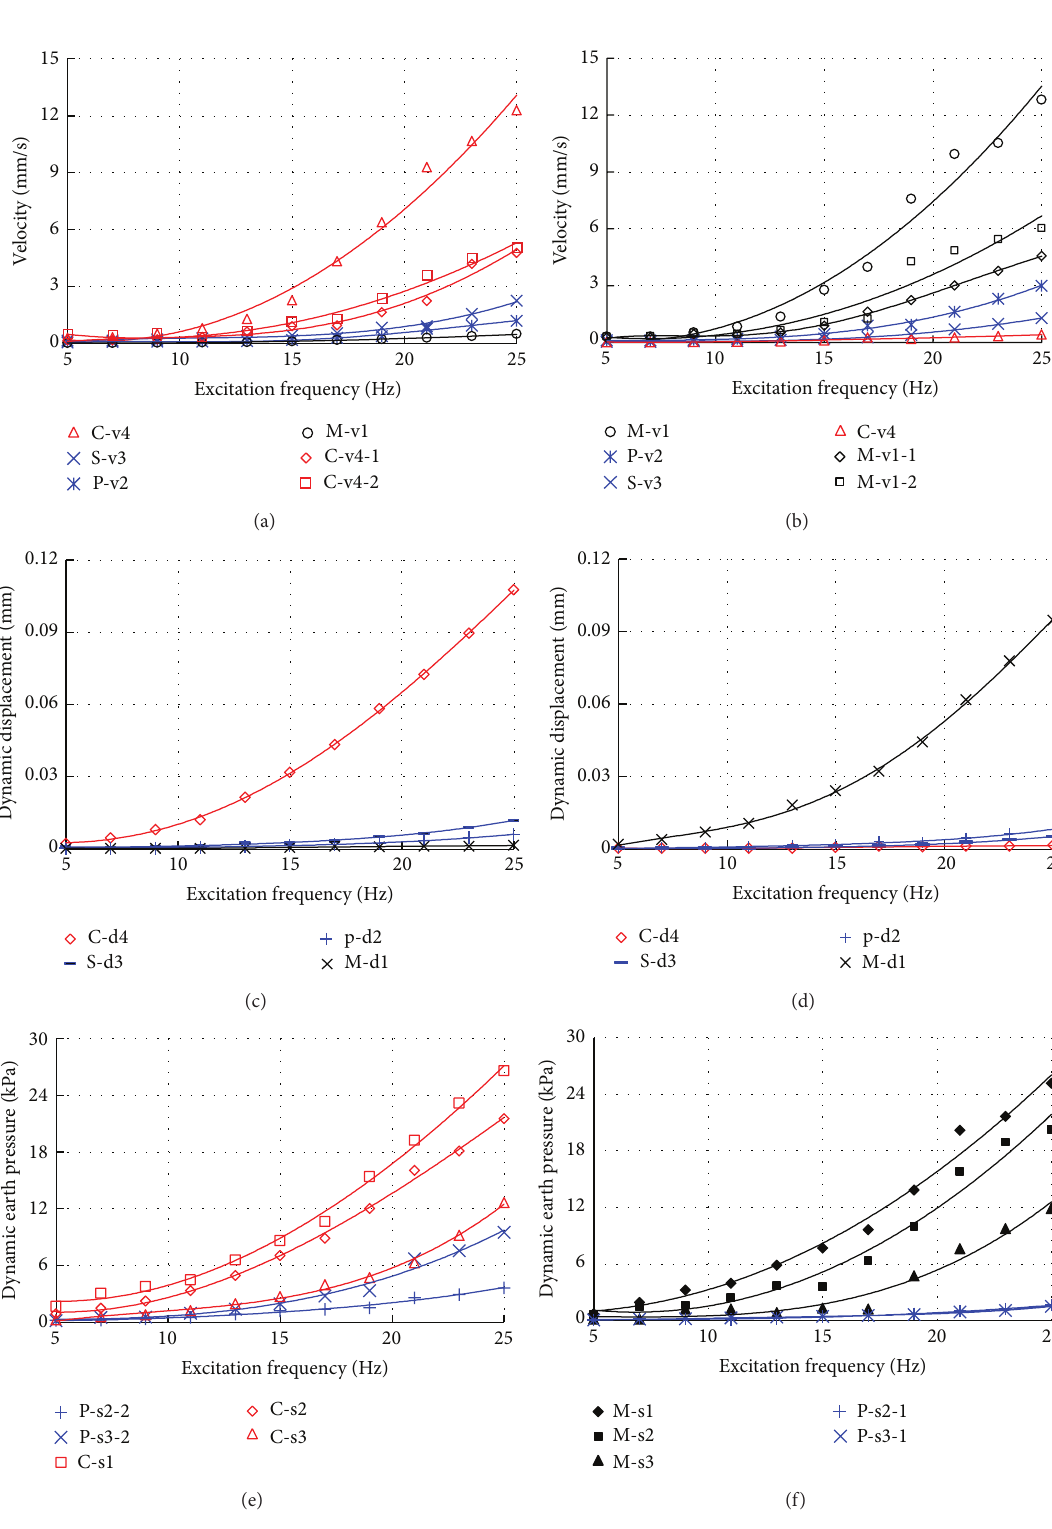
Figure 11: Vertical velocity, dynamic displacement, and dynamic soil pressure of subgrade versus vibration frequency. (a), (c), and (e) show vibration force acting on section II-II. (b), (d), and (f) show vibration force acting on section